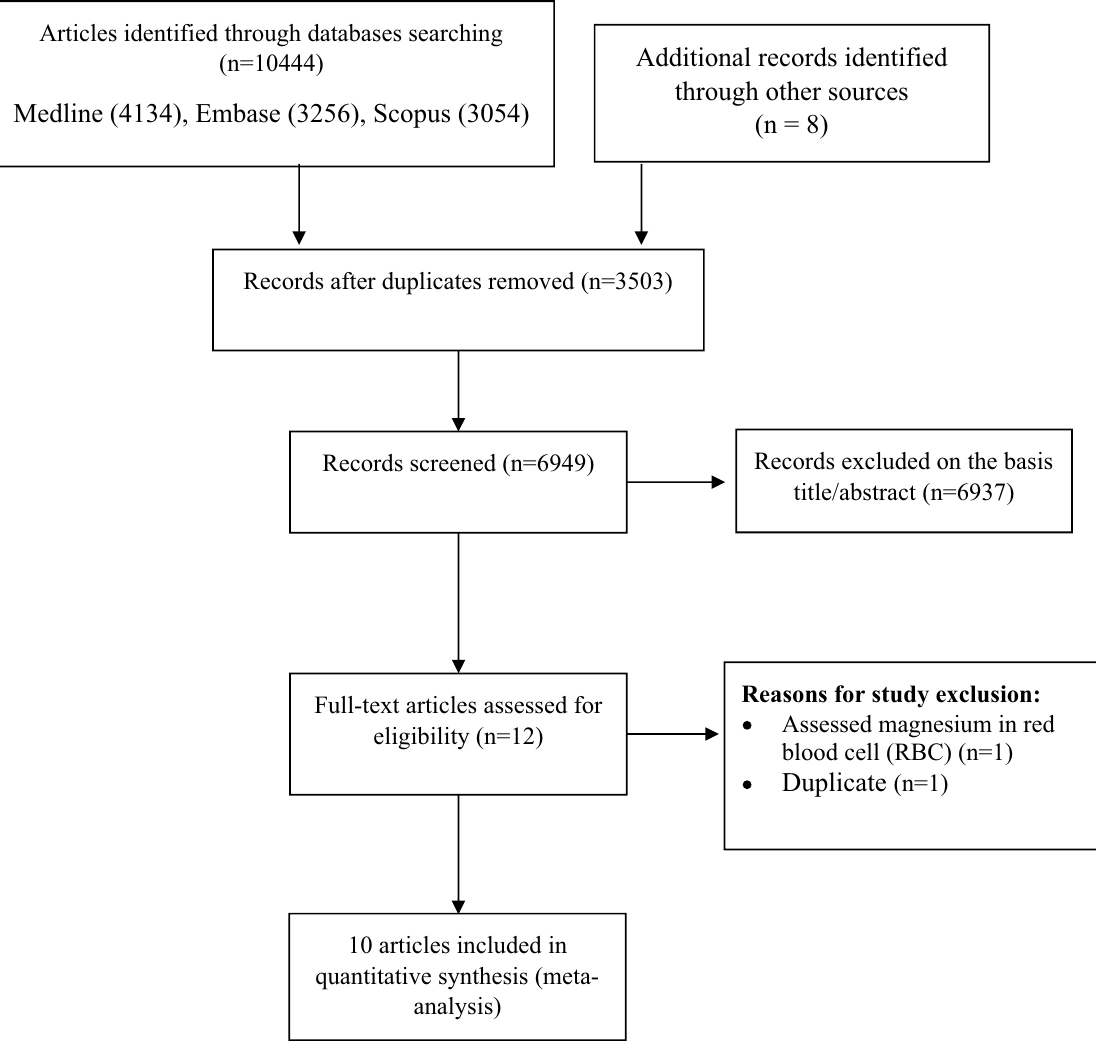
Figure 1. PRISMA flowchart describing the study’s systematic literature search and study